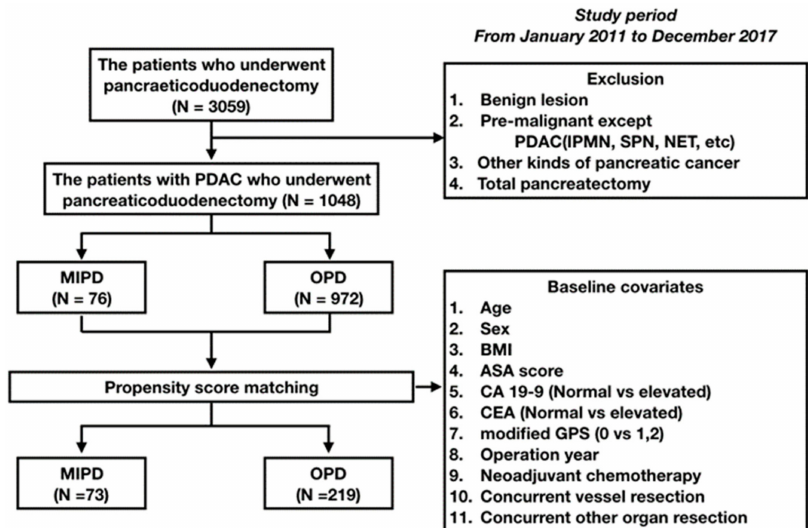
Figure 1. Patient flow diagram. We conducted a retrospective review of 1048 patients who underwent pancreatoduodenectomy after excluding 2011 patients based on the criteria listed in the figure. Of these, 76 patients underwent minimally invasive pancreatoduodenectomy and 972 patients underwent open pancreatoduodenectomy. After propensity score matching, 73 MIPD patients and 219 OPD patients were